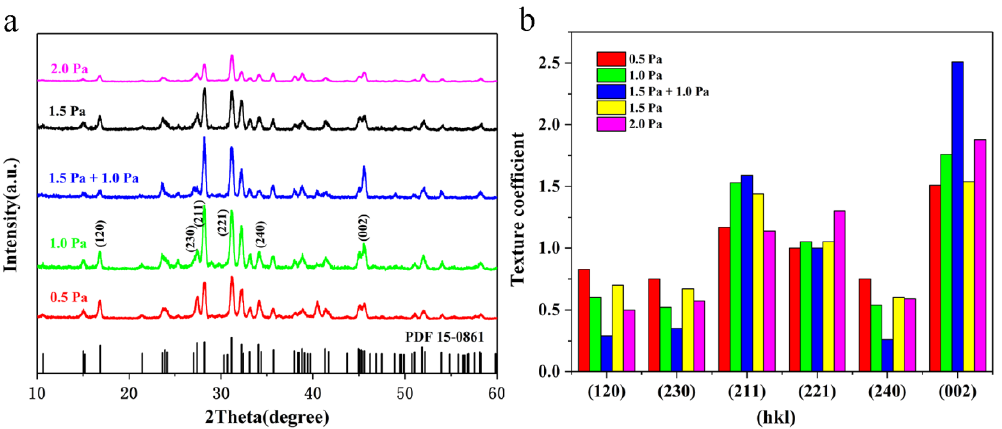
Figure 4. Morphology evolutions of Sb 2 Se 3 thin films. XRD data of crystallized Sb 2 Se 3 thin films ( a ). Texture coefficients ( TC ) of crystallized Sb 2 Se 3 thin films ( b ).